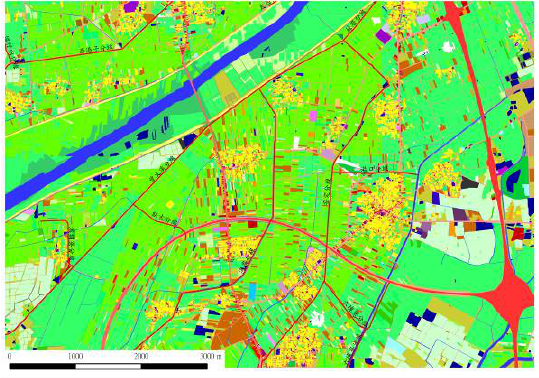
Figure 6. The Land Use Investigation of